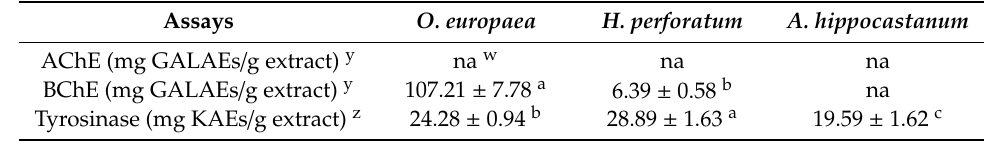
Table 6. Enzyme inhibitory activities of the water extracts from plants x .